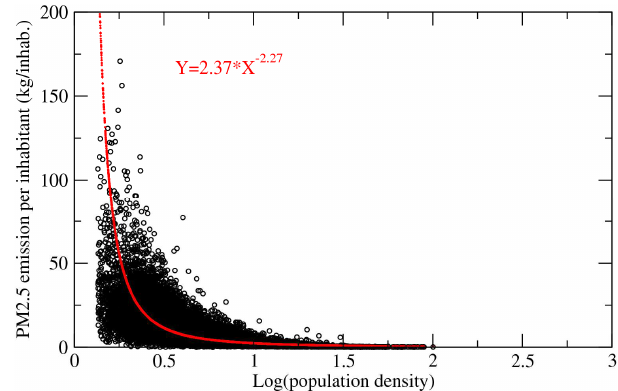
Figure 3. Evolution of PPM 2 . 5 residential emissions per inhabi- tant (kg/inhab/year) as a function of population density (source: French National Emission Inventory). The red curve is the corre- sponding logarithmic regression used in the CHIMERE emission pre-processor.